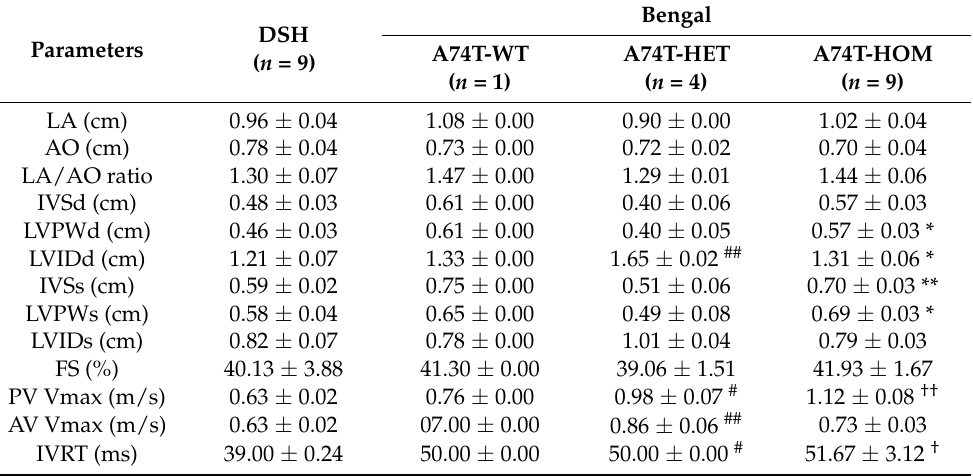
Table 2. Echocardiographic parameters of the study